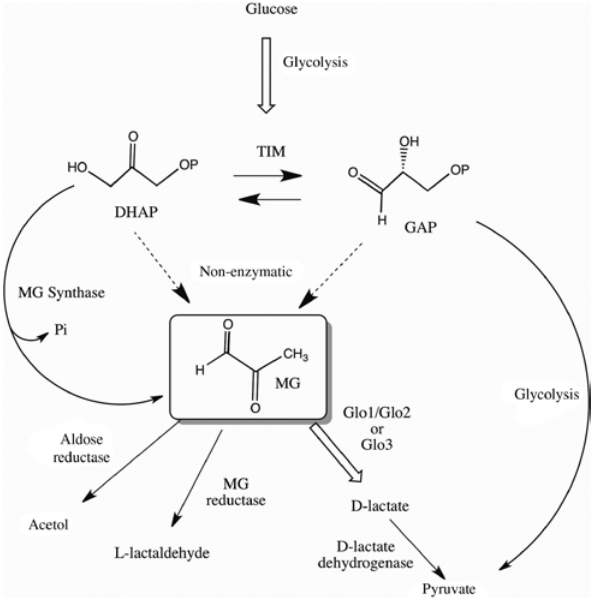
Figure 2: Some of the biological pathways that lead to and from MG including the position of the enzymes Glo1, Glo2 and